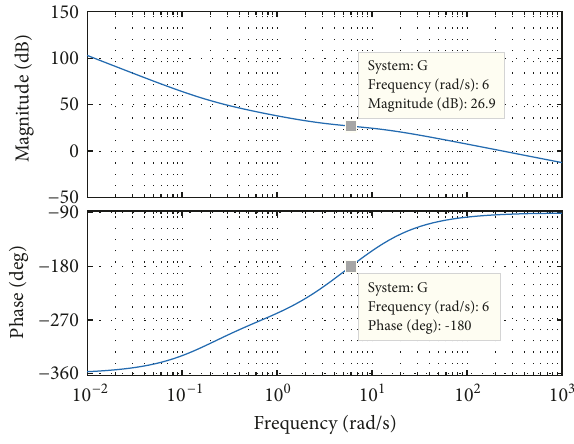
Figure 8: Bode diagrams of 𝐺(𝑠) .